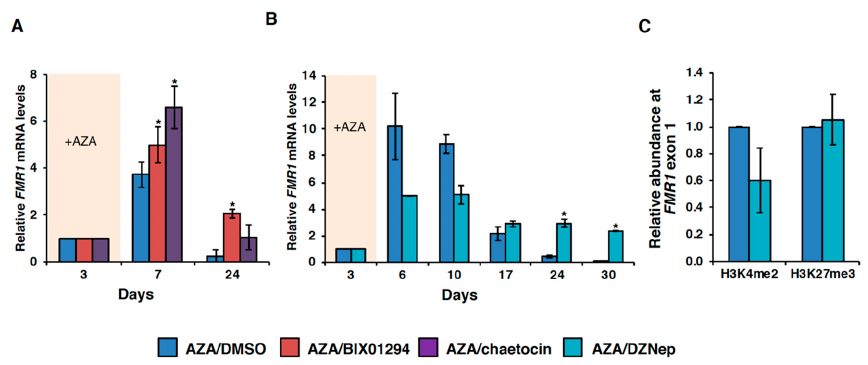
Figure 4. (A , B) Effect of BIX01294, chaetocin and DZNep in delaying re-silencing of AZA reactivated FM allele in FXS lymphoblastoid cell line GM04025. Cells were treated with 10 µM AZA for 72 h and split and treated with either DMSO or indicated HMT inhibitor for up to 30 d, adding fresh media HMT inhibitor every 3 d. The FMR1 mRNA levels were measured by RT-qPCR and normalized to the levels of GUS mRNA and are shown relative to day 3. Data shown are from at least two independent treatments. ( C ) The levels of histones H3K4me2 and H3K27me3 on FMR1 exon1 were analyzed in GM04025 cells treated with AZA/DMSO or AZA/DZNep at day 10 by ChIP-qPCR. Data are shown relative to AZA/DMSO and are an average of three independent experiments. Error bars represent standard deviation, and statistically significant differences are indicated by an asterisk ( p < 0.05).